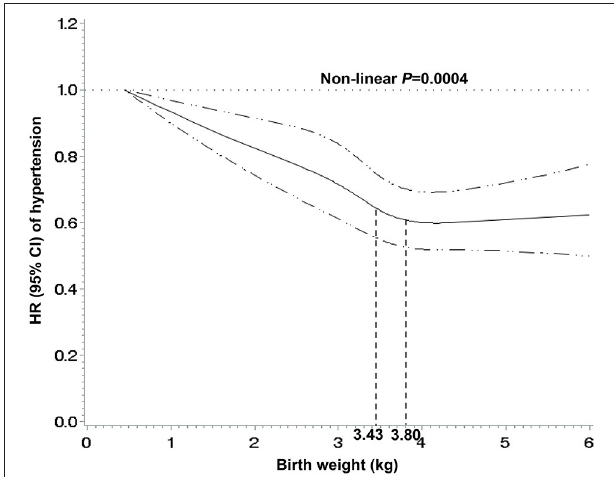
FIGURE 1 | Nonlinear associations between birth weight and risk of hypertension. The associations were examined by multivariate Cox regression models based on restricted cubic splines. Participants with birth weight > 6kg were not included ( n = 147). Solid line represents estimates of hazard ratios and dashed line represents 95% confidence